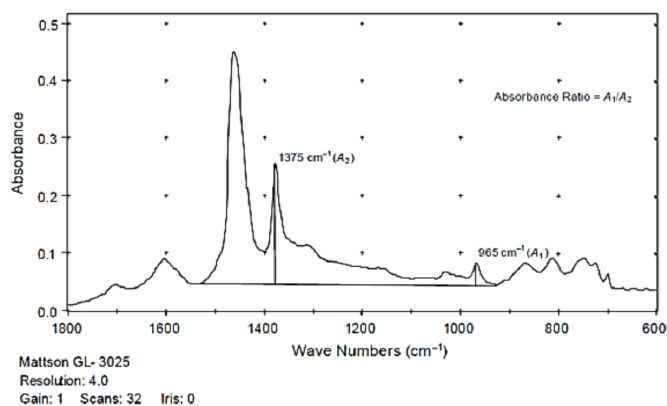
Figure 3. Example determination of A1 and A2 values in the transmission mode of analysis, according to AASHTO T302–15 [32].